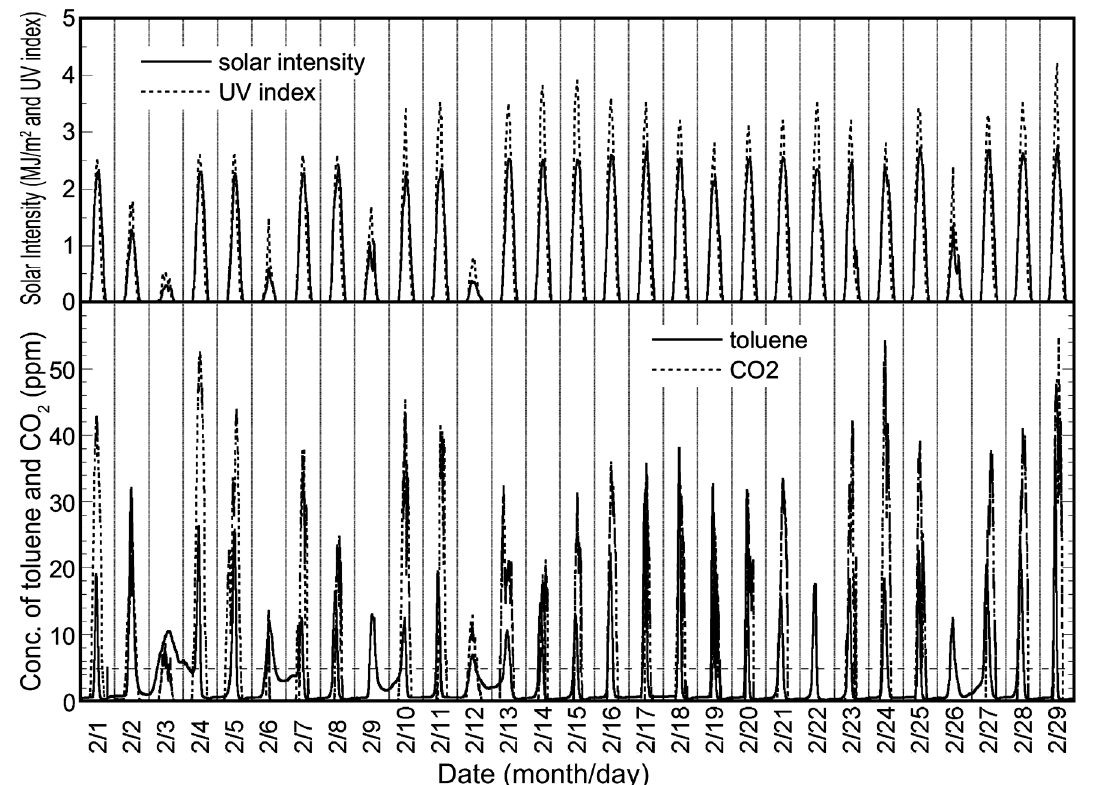
Figure 6. Experimental data for February 2008, obtained using the reactor installed with a HQC21-packed glass